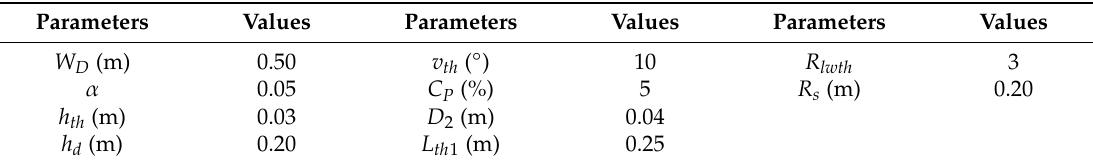
Table 1. Parameters used in the process.